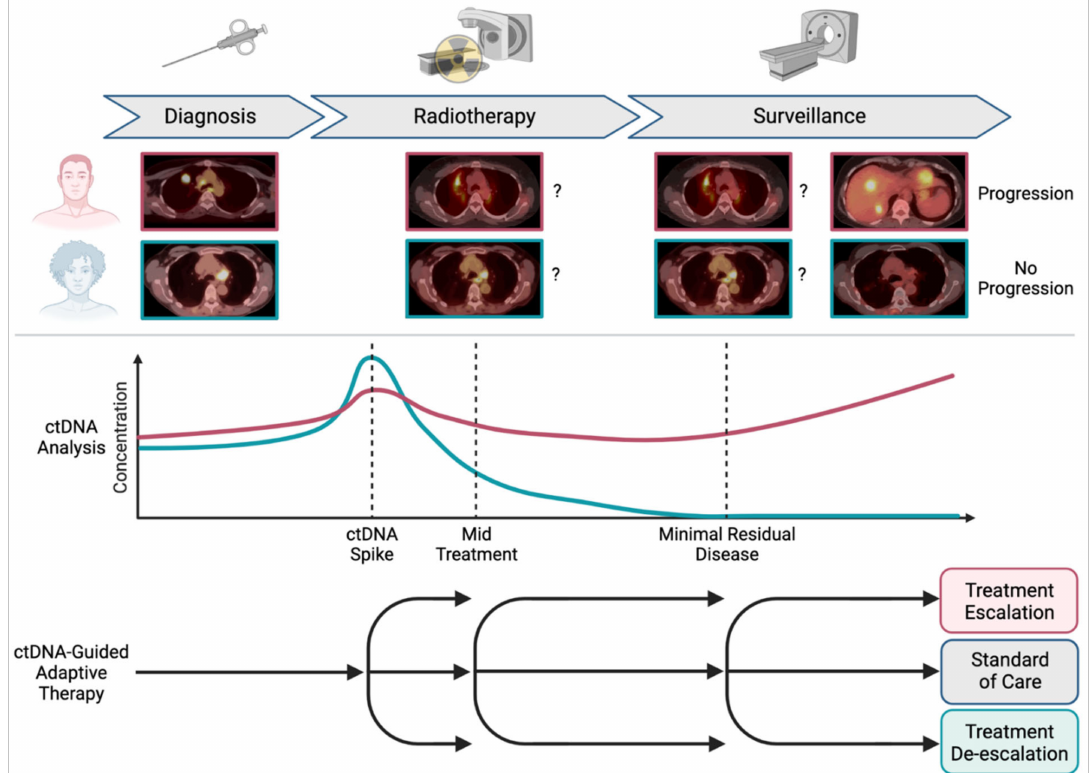
Figure 1. Tracking radiotherapy response using circulating tumor DNA (ctDNA) analysis. Two patients with cancer undergo definitive radiotherapy, with one patient ultimately progressing (pink) and the other patient being cured (teal). Standard radiographic imaging during radiotherapy and follow up is inconclusive due to radiographic similarities between viable tumor and other benign processes such as inflammation. In contrast, ctDNA changes during radiotherapy may identify early and mid-treatment ctDNA changes associated with response to treatment. After completing radiotherapy, ctDNA minimal residual disease can identify patients who are at risk of relapse. Escalating or de-escalating treatment based on ctDNA levels may improve the probability of cure while minimizing the risk of